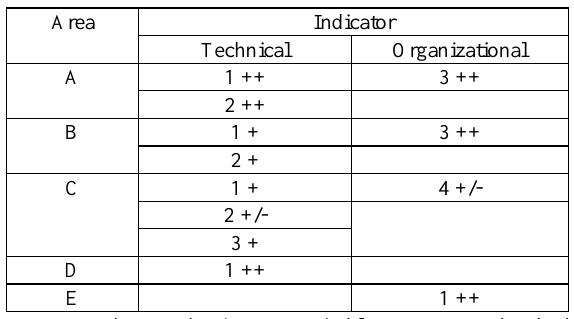
Table 3. Evaluation of Canadian